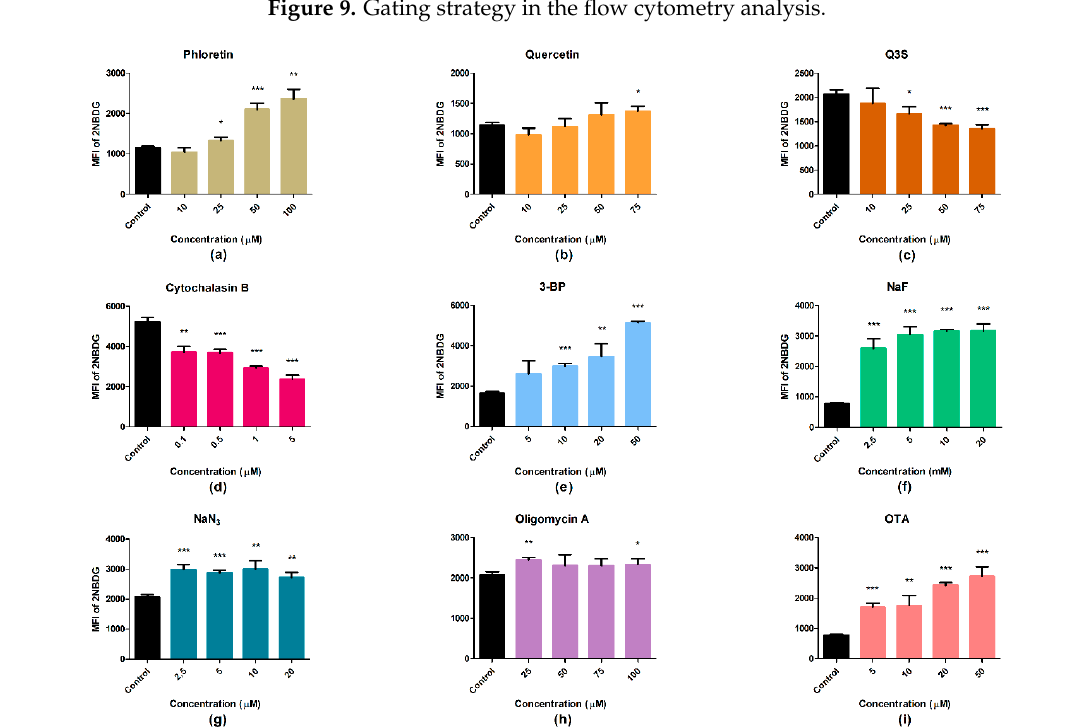
Figure 10. 2-[N-(7-nitrobenz-2-oxa-1,3-diazol-4-yl)amino]-2-deoxyglucose (2-NBDG) uptake in HepG2 cells as a result of ( a ) phloretin, ( b ) quercetin, ( c ) Q3 (cid:48) S, ( d ) cytochalasin B, ( e ) 3-BP, ( f ) NaF, ( g ) NaN 3 , ( h ) oligomycin A, and ( i ) OTA treatment. Incubation time with metabolic inhibitors: 4 h, 2-NBDG: 1 h. MFI, mean fluorescence intensity. Columns represent the mean of medians, error bars show the interquartile range of fluorescence intensity of intracellular 2-NBDG. PI-positive cells are excluded from the analysis. (* p < 0.05, ** p < 0.01, *** p < 0.001 compared with controls.)